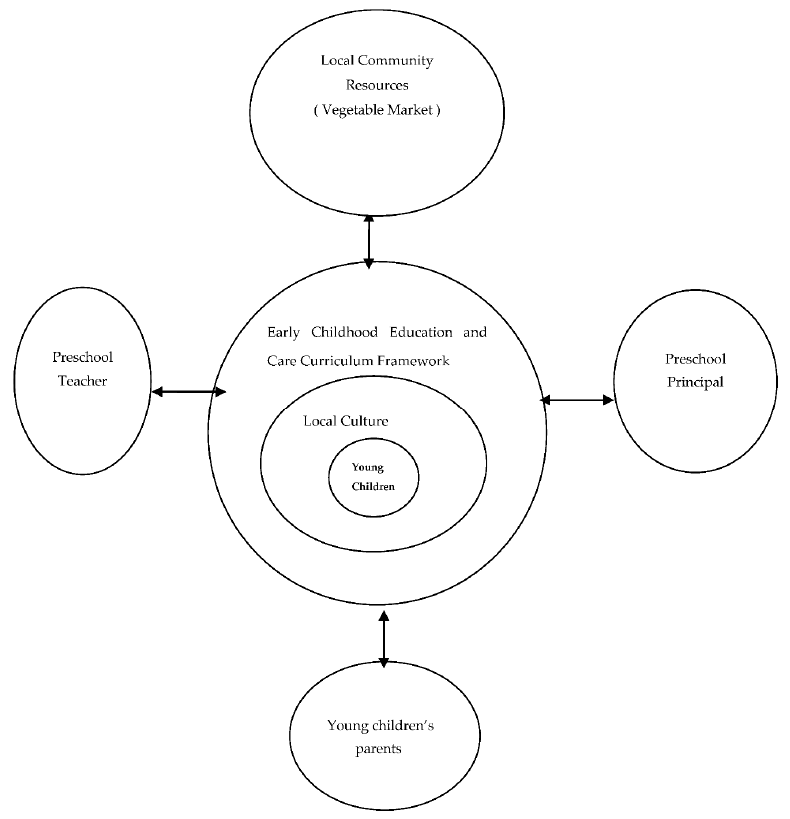
Figure 1. Theoretical Framework. (Source: Developed in this study).